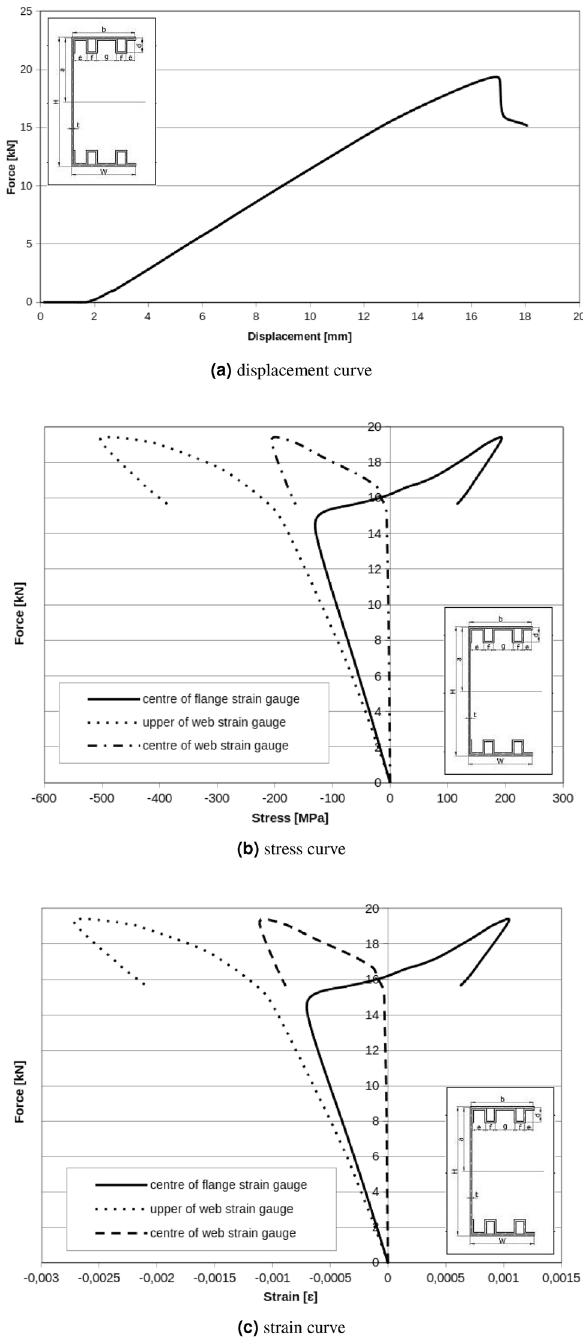
Figure 15. Double box flanges and reinforcement parts with